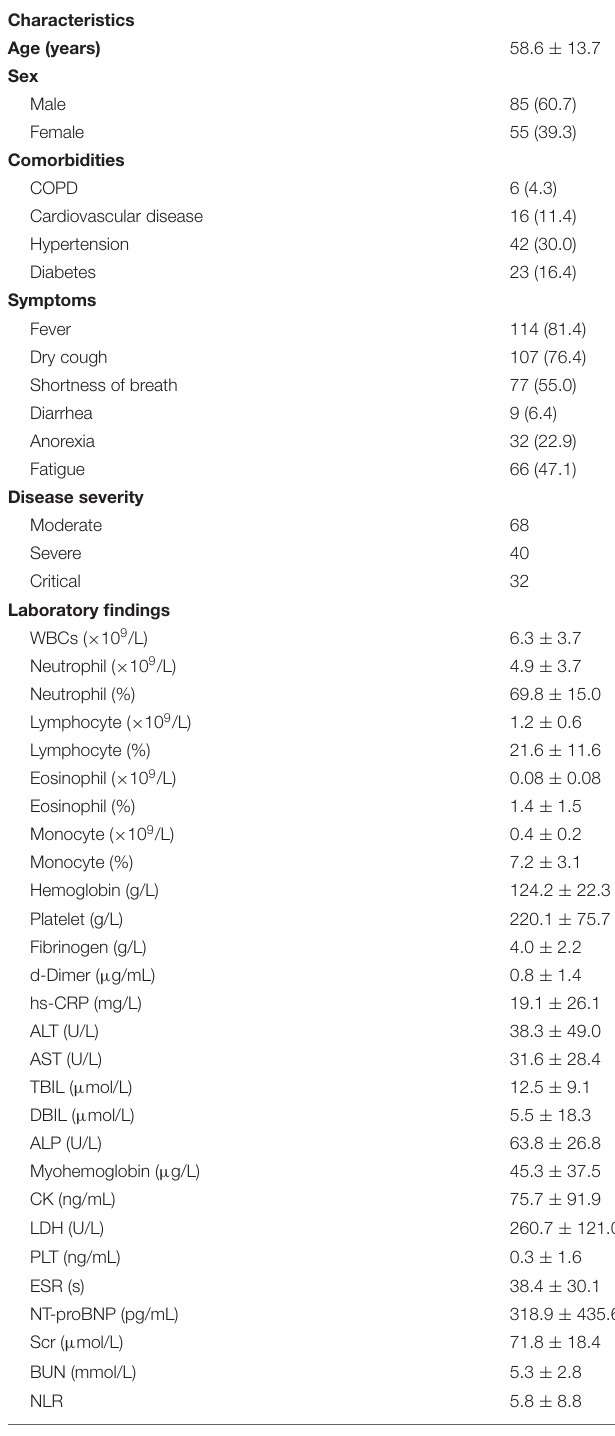
TABLE 1 | Clinical characteristics of